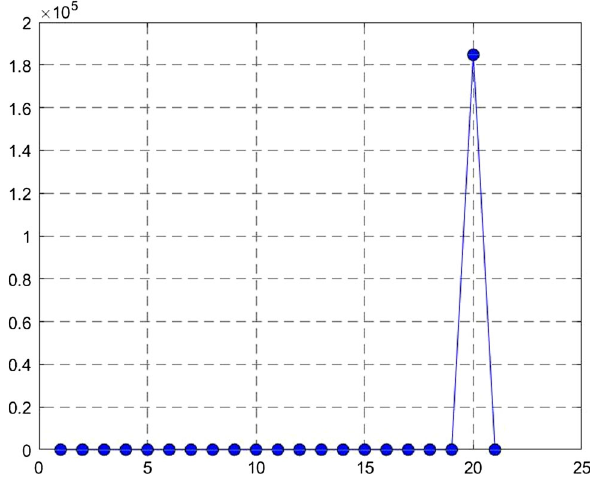
Fig. 6 Path length distribution for the 121-point square lattice in Fig. 5. This lattice can certainly be embedded in 2D Minkowski space, but we see from Fig. 2 that because of its peak position at k = 20 and width Δ = 1 it fails our manifoldlikeness